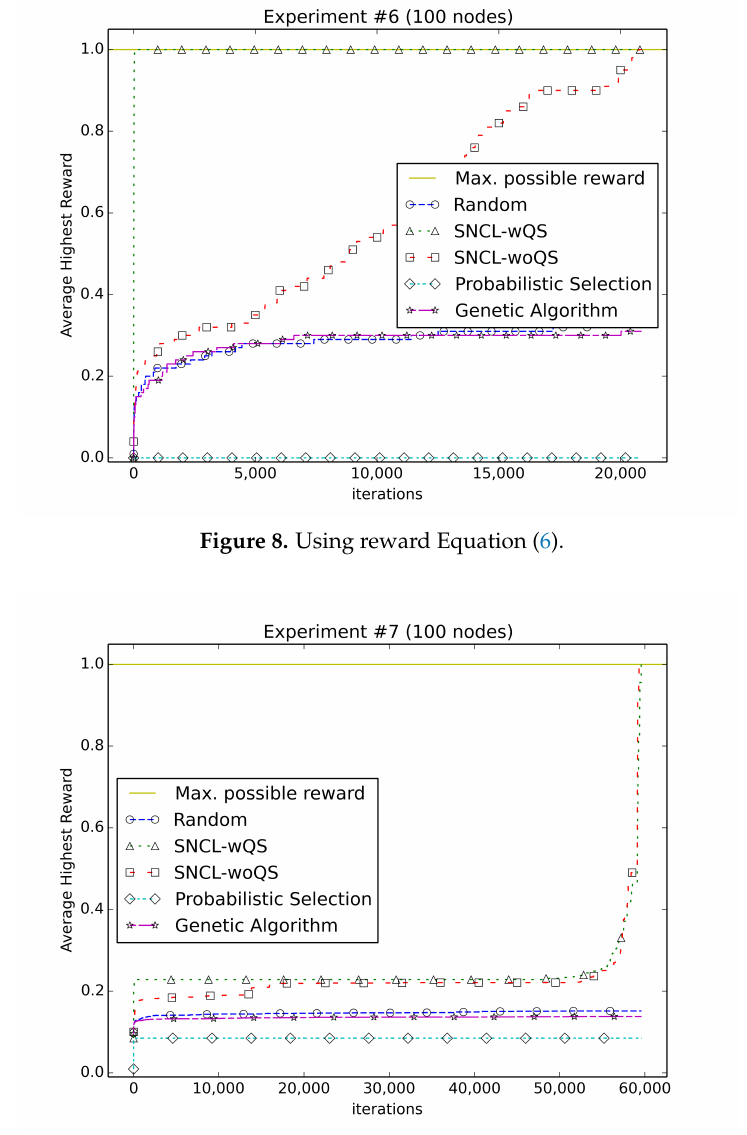
Figure 9. Using reward Equation